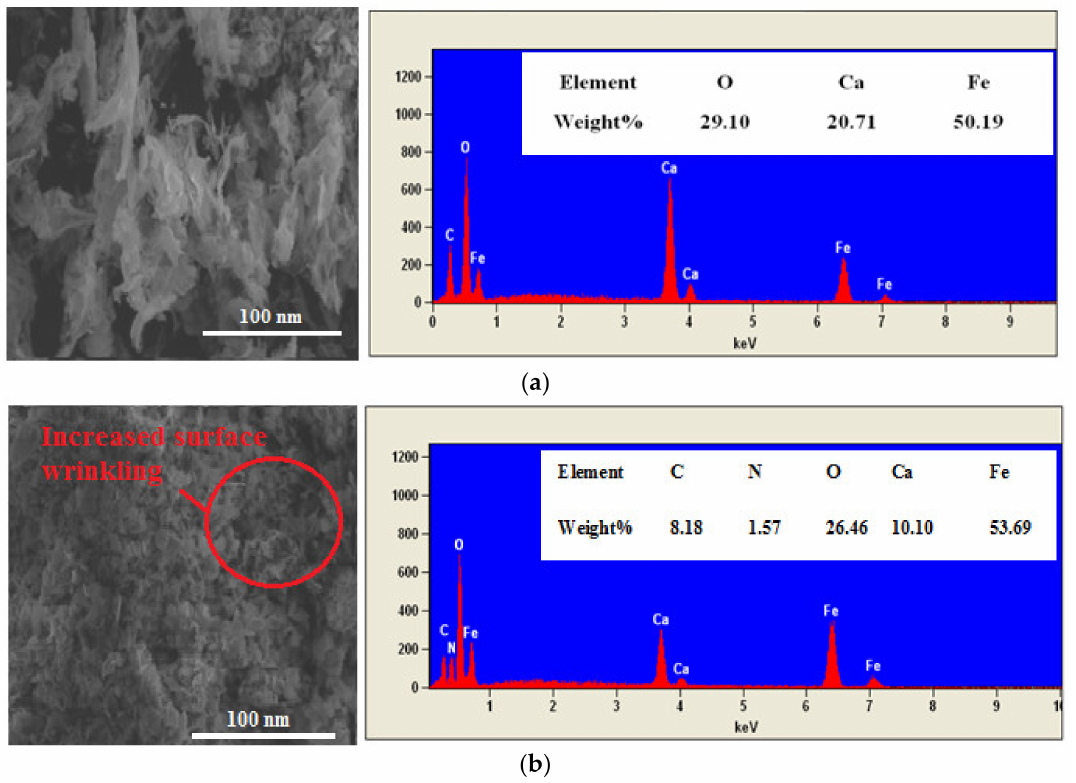
Figure 2. SEM-EDS of ( a ) CaFe 2 O 4 and ( b ) CaFe 2 O 4